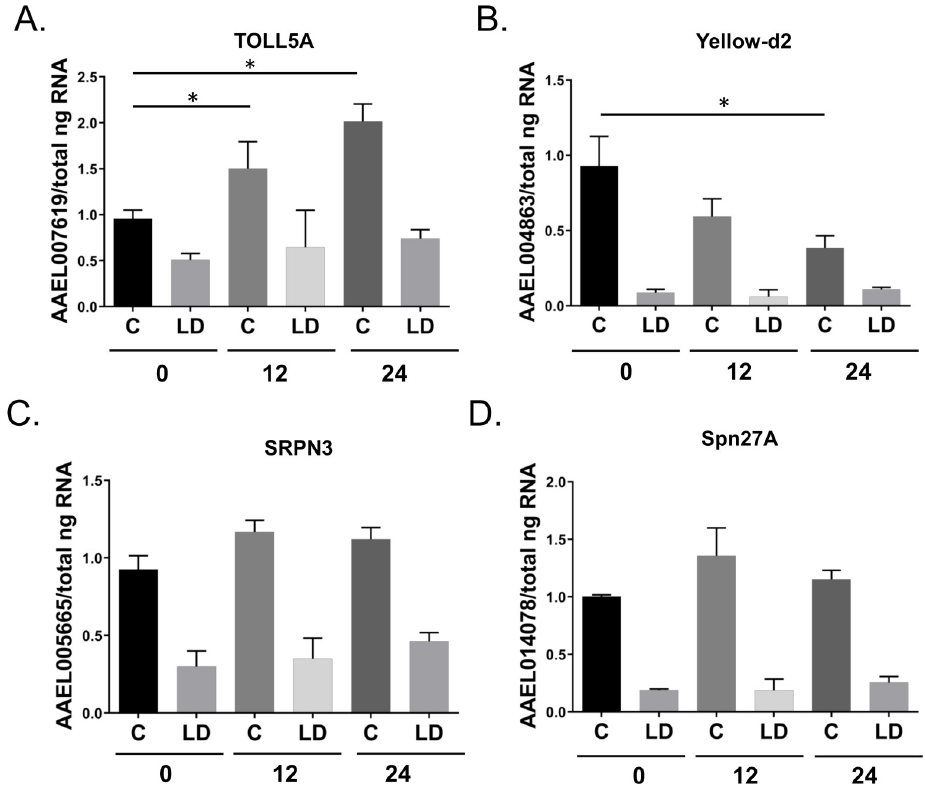
Fig 8. Gene expression validation using uninfected and DENV-infected C and LD-Aag2 cells reveals a blunted innate immune response in LD-Aag2 cells. (A-D) Representative genes were selected that had differential gene expression in the RNA-Seq dataset (i.e., AAEL007619, AAEL004863, AAEL005665, and AAEL014078). C and LD-Aag2 cells were infected with DENV and gene expression was determined 0, 12, and 24 hours post infection. Assays were performed in triplicate. Unpaired Student’s t tests were performed between groups to assess statistical significance. Standard deviations are shown.